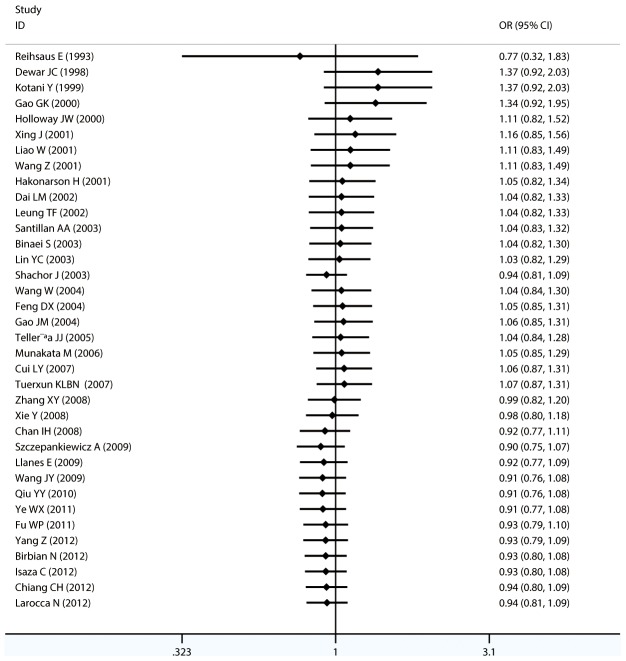
Forest plots of cumulative meta-analysis of Gln27Glu (rs1042714) in association with asthma by published year under recessive model comparison.